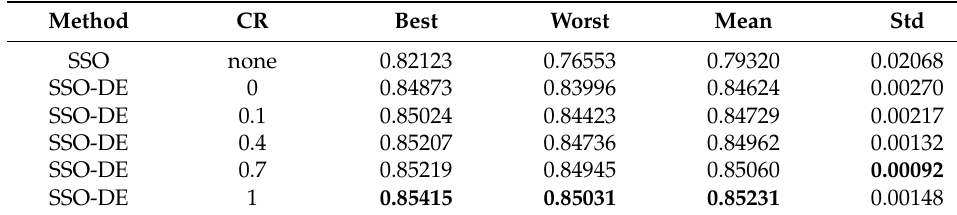
Table 20. Comparison of SSO and SSO-DE for winter.